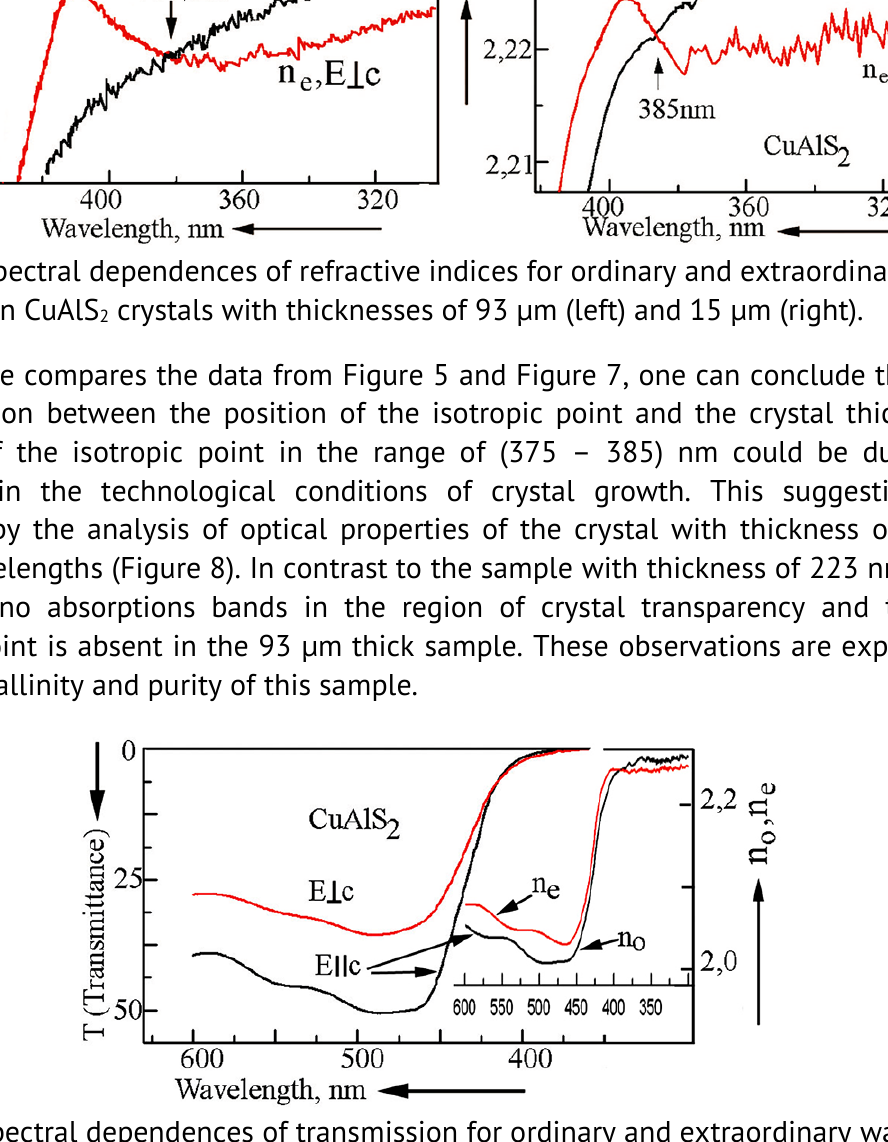
Figure8. Spectral dependences of transmission for ordinary and extraordinary waves in a CuAlS crystal with thicknesses of 93 2